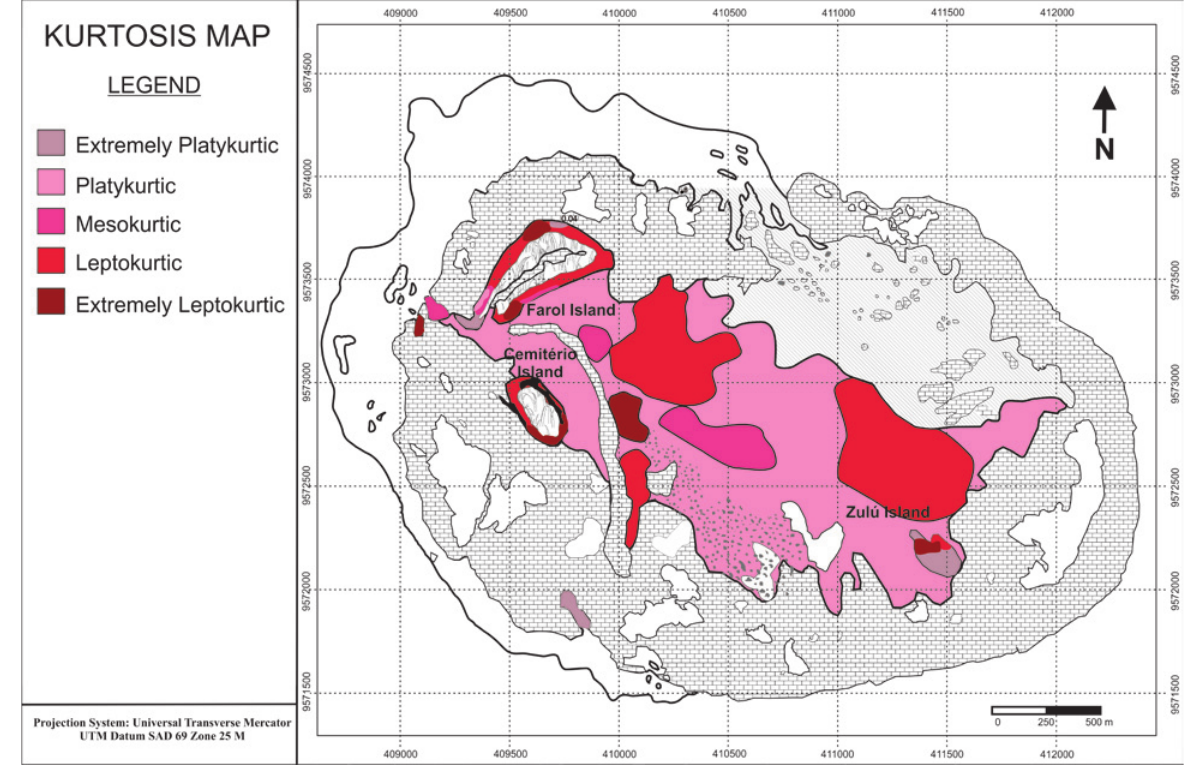
Figure 13 - Skewness map of Rocas